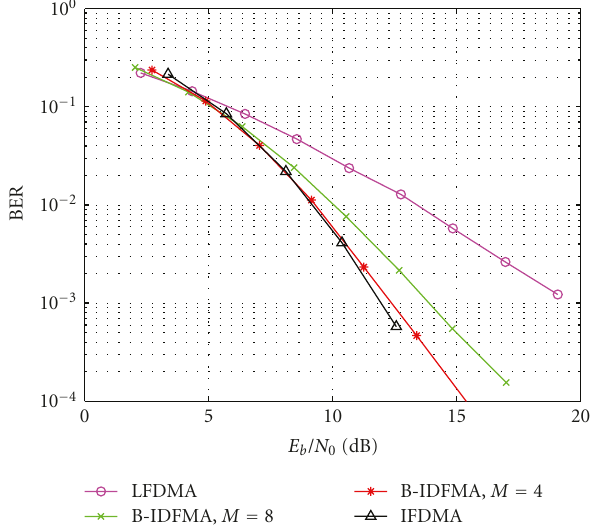
Figure 9: Coded SISO performance for B-IFDMA, IFDMA and LFDMA with nonperfect channel estimation, and Q = 32 subcarriers assigned per user. The Block-LSE channel estimation performance results from Figure 8 are used. B-IFDMA uses block of sizes ( M = 4, N t = 6) or ( M = 8, N t = 6).